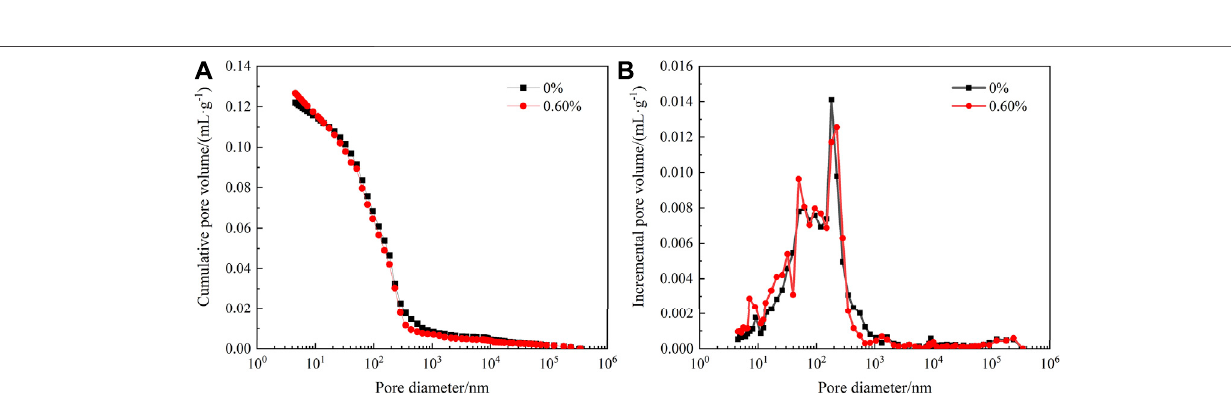
Frontiers in Materials |